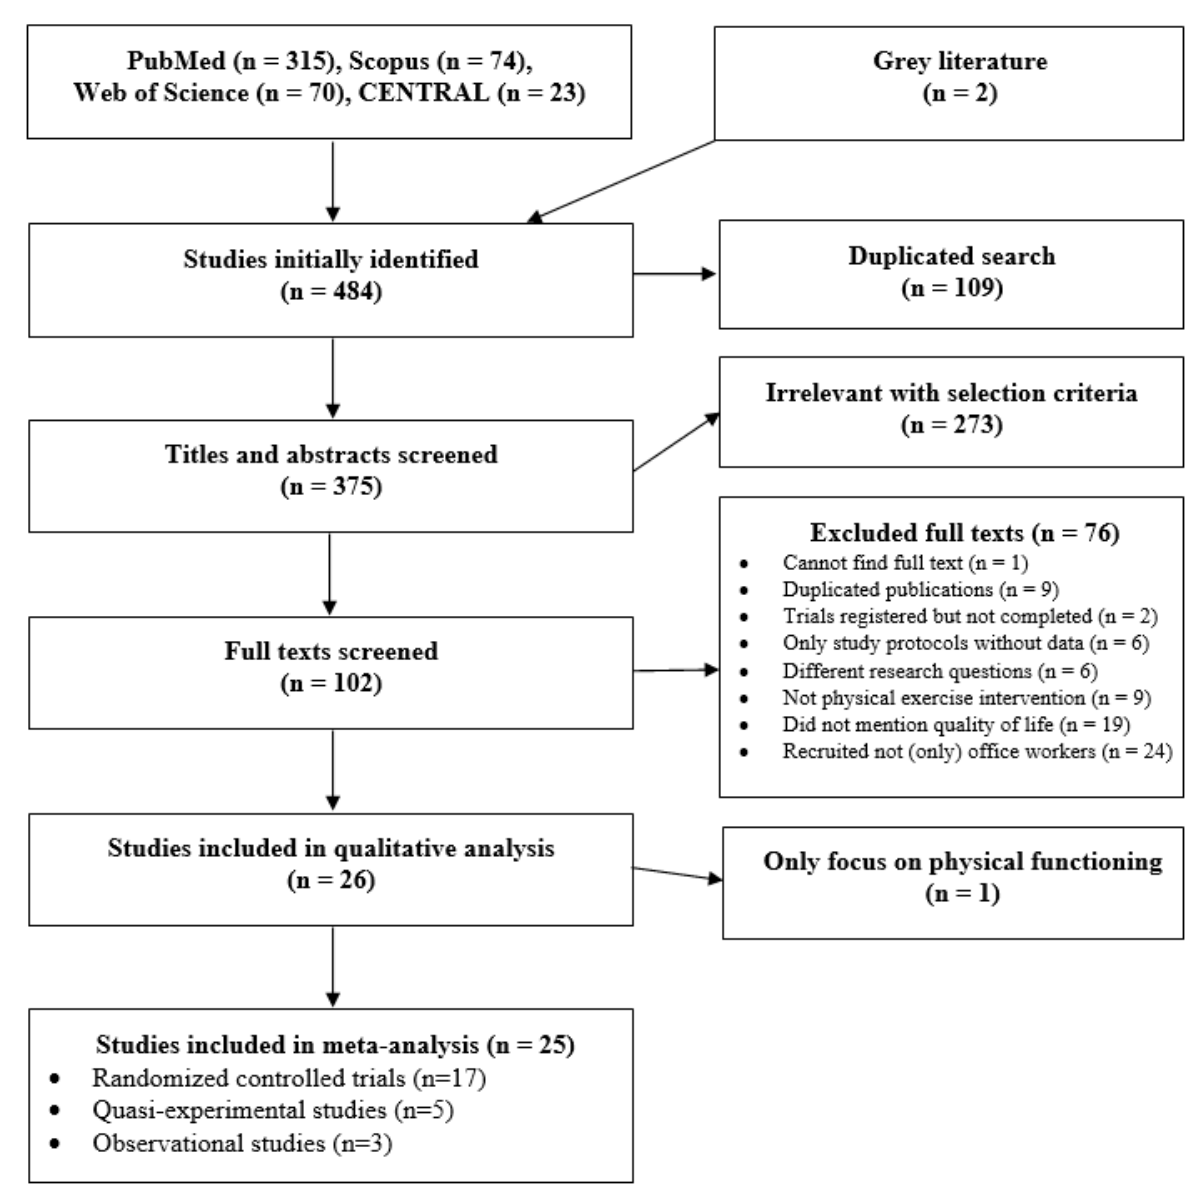
Figure 1. Flow chart of the study selection process.